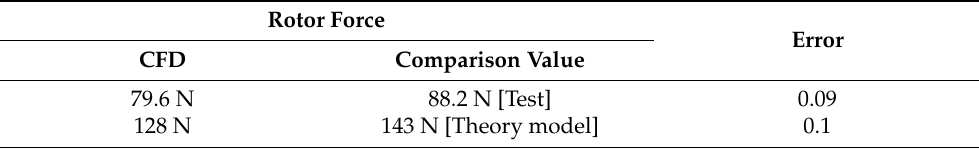
Figure 10. The induced velocity at the rotor disk. Table 3. Validation of the CFD and momentum ‐ element model.